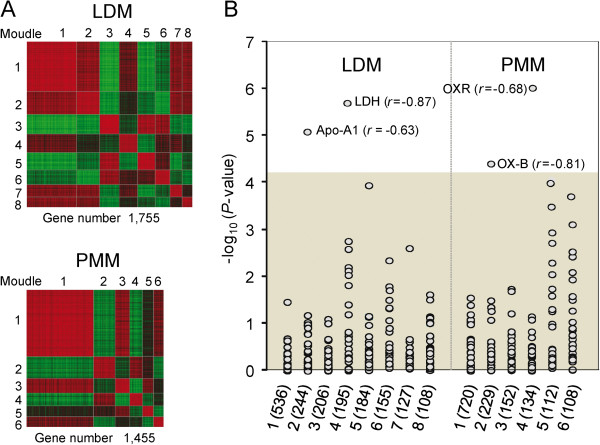
Analysis of coexpressed gene modules in LDM and PMM. (A) Heat map of coexpressed gene modules in longissimus dorsi muscle (LDM) and psoas major muscle (PMM). Gene pairs strongly positively or negatively correlated are shown in red or green, respectively. (B) Correlations between coexpressed gene modules in two muscle tissues and phenotypic traits. -Log P-values for Spearman correlation coefficients between the values of the modules and the different phenotypic traits are shown. The gray shadow represents a highly stringent Bonferroni corrected P-value of 0.05.